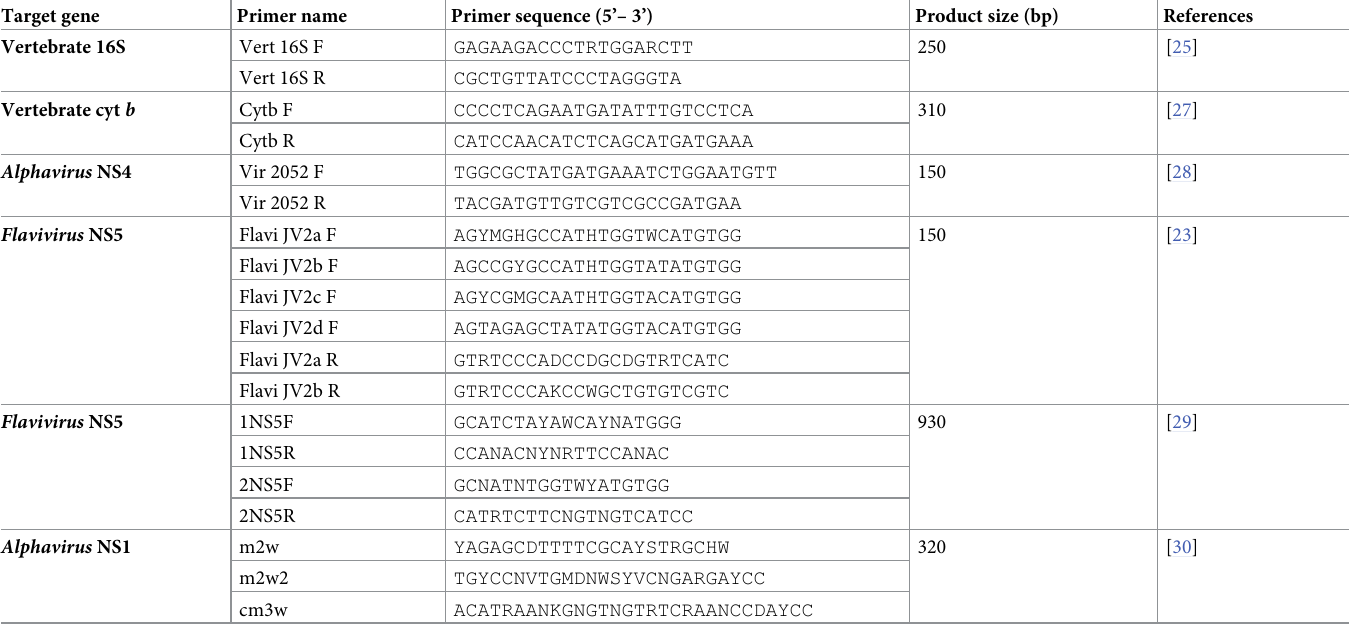
Table 1. Primers used for blood-meal and arboviral identification. Target